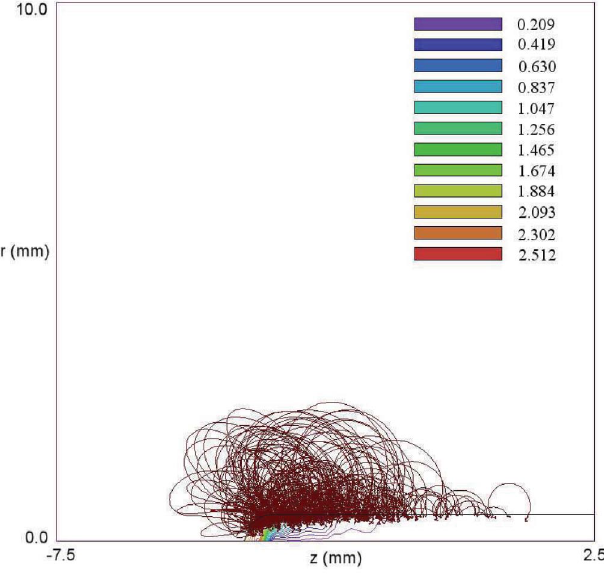
FIG. 10. (Color) Selected primary electron orbits and dose-rate distribution ( Gy = s ) in the target for the CRAD baseline simula- tion. Multiply values by 10 15